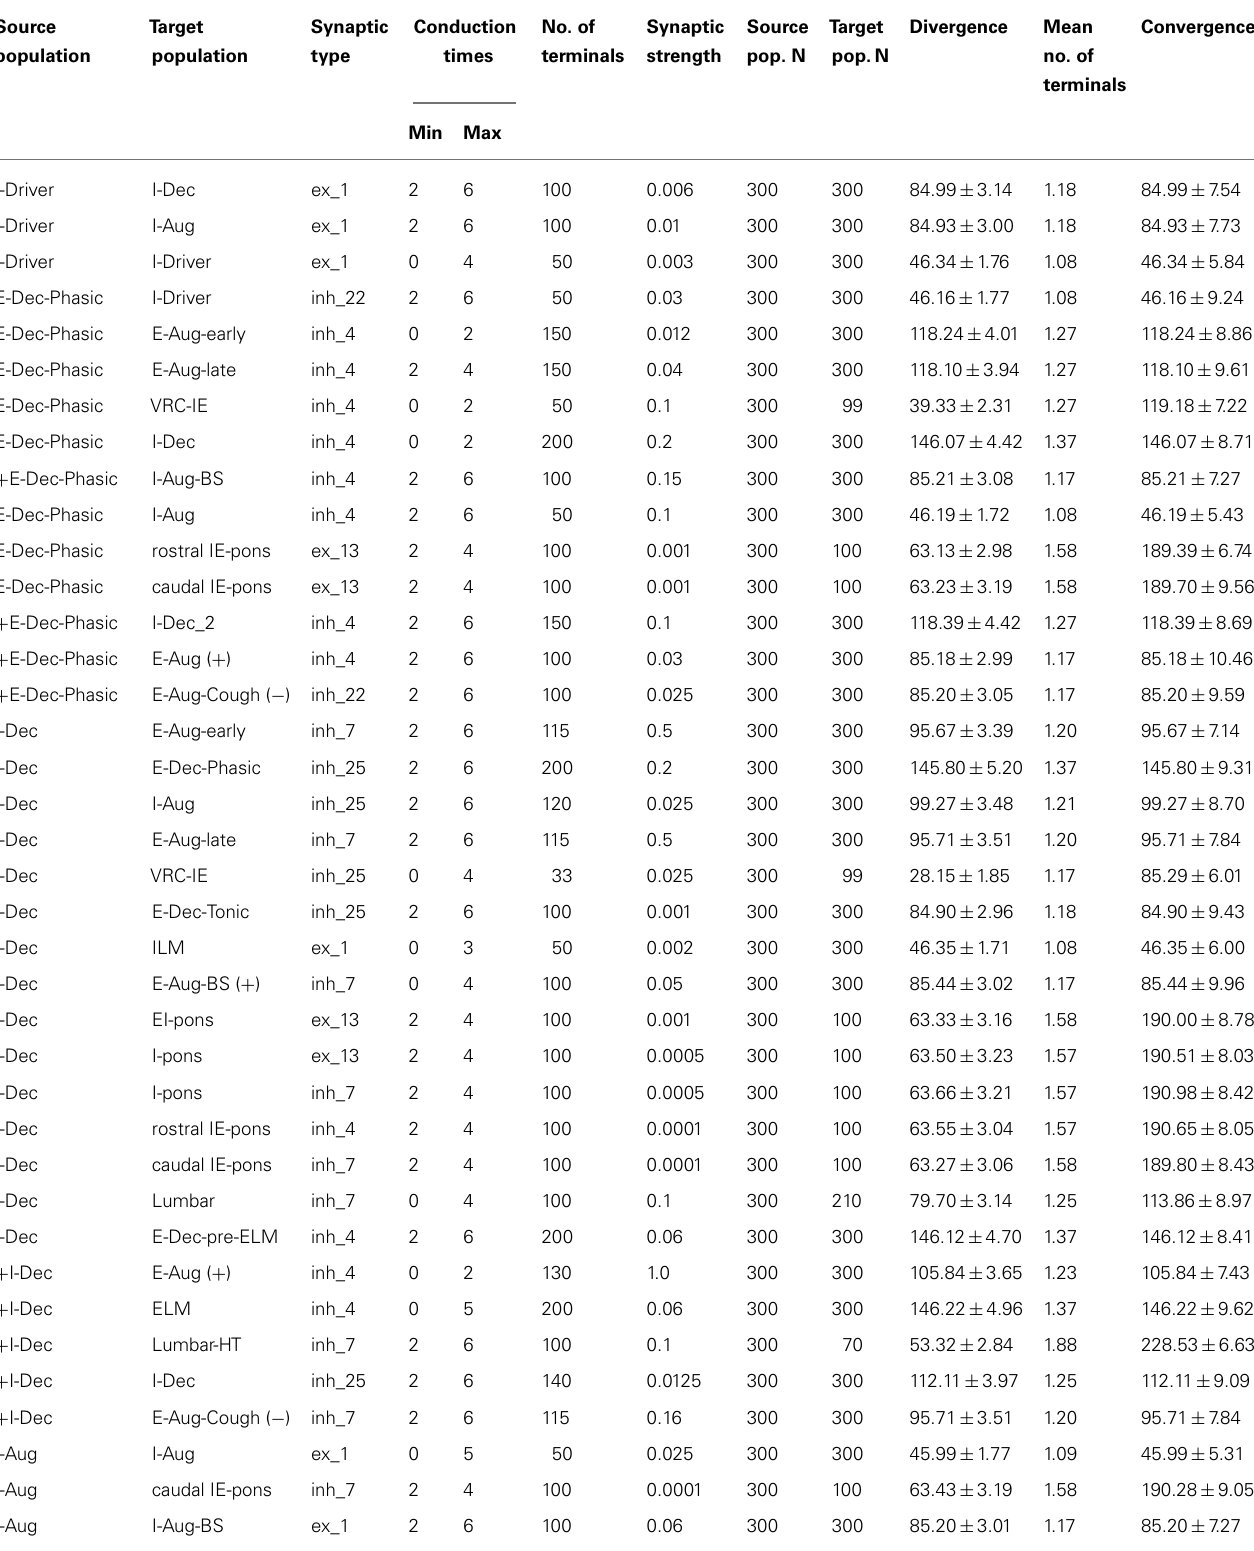
Table 4 | Connectivity for the network model modified from Poliaˇcek et al.